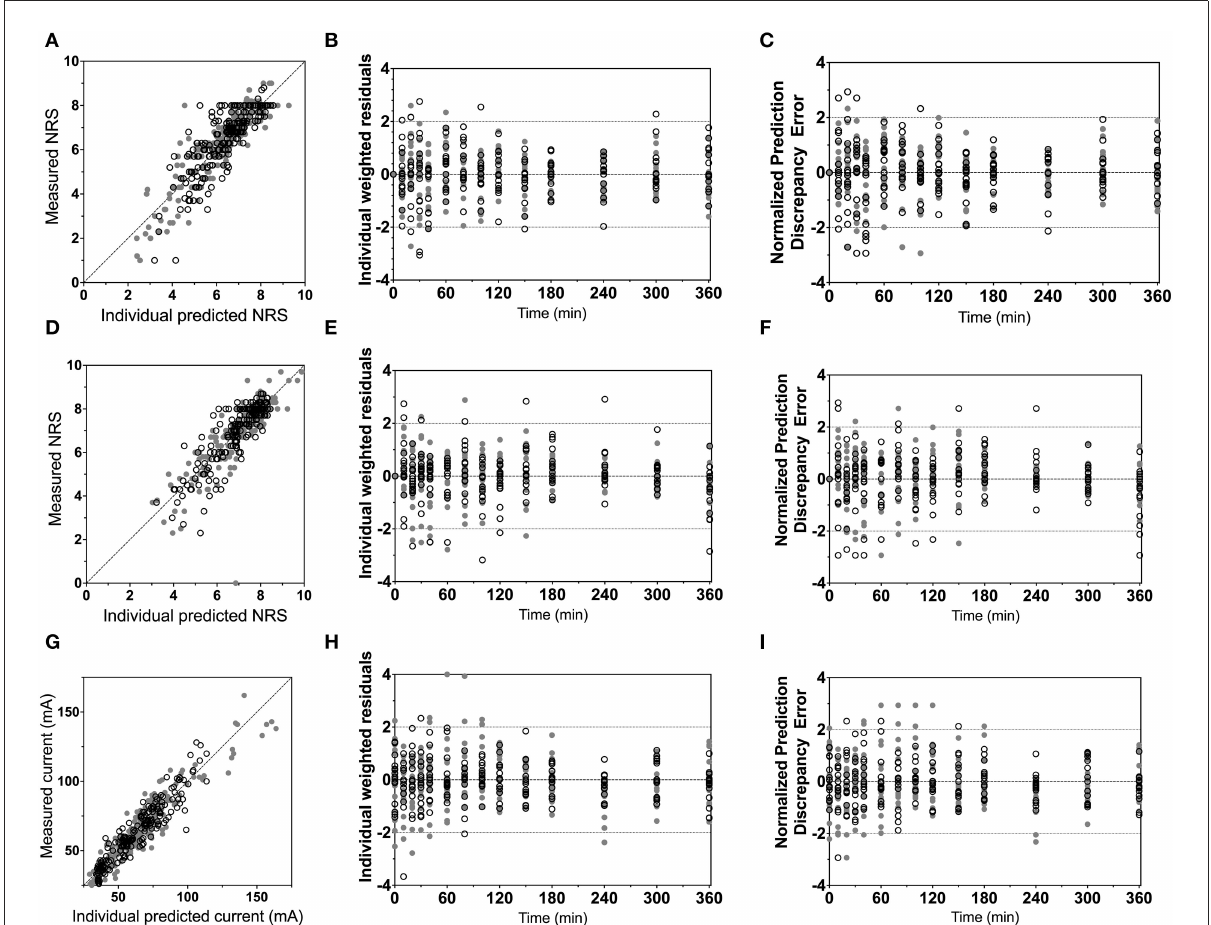
FIGURE3 Goodness-of-fit plots. (A–C) Electrical pain numerical rating scale; (D–F) heat pain numerical rating scale; (G–I) pressure pain threshold. (A,D,G) Measured vs. individual predicted; (B,E,H) individual weighted residuals vs. time. (C,F,I) Normalized prediction discrepancy errors vs. time. Dashed lines are the 95% confidence intervals. Open circles denote data from the 50mg S- ketamine oral thin film and closed circles data from the 100mg S- ketamine oral thin